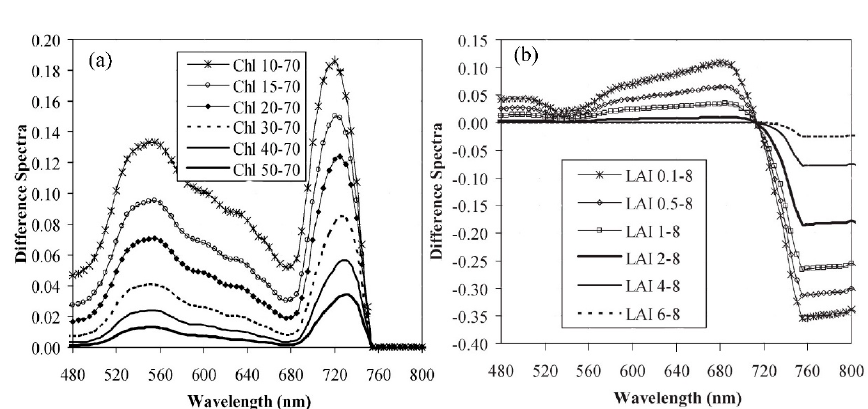
Figure 2. Relative di ff erence in canopy reflectance [32]. ( a ) Di ff erence between reflectance spectra corresponding to various chlorophyll contents and reflectance spectra corresponding to LCC = 70 µ g cm − 2 . In the legend, Chl 30–70 is the di ff erence between the reflectance spectra corresponding to LCC = 30 and 70 µ g cm − 2 . ( b ) Di ff erence between reflectance spectra representing various LAI values and the spectrum corresponding to LAI = 8. The legend follows the same format as in the left